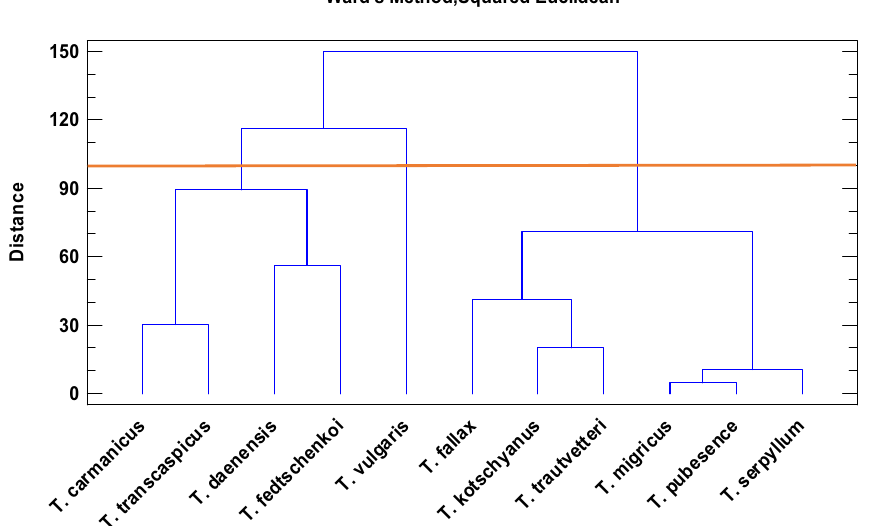
Figure 2. Cluster analysis of studied Thymus species according to major polyphenolic profiles.